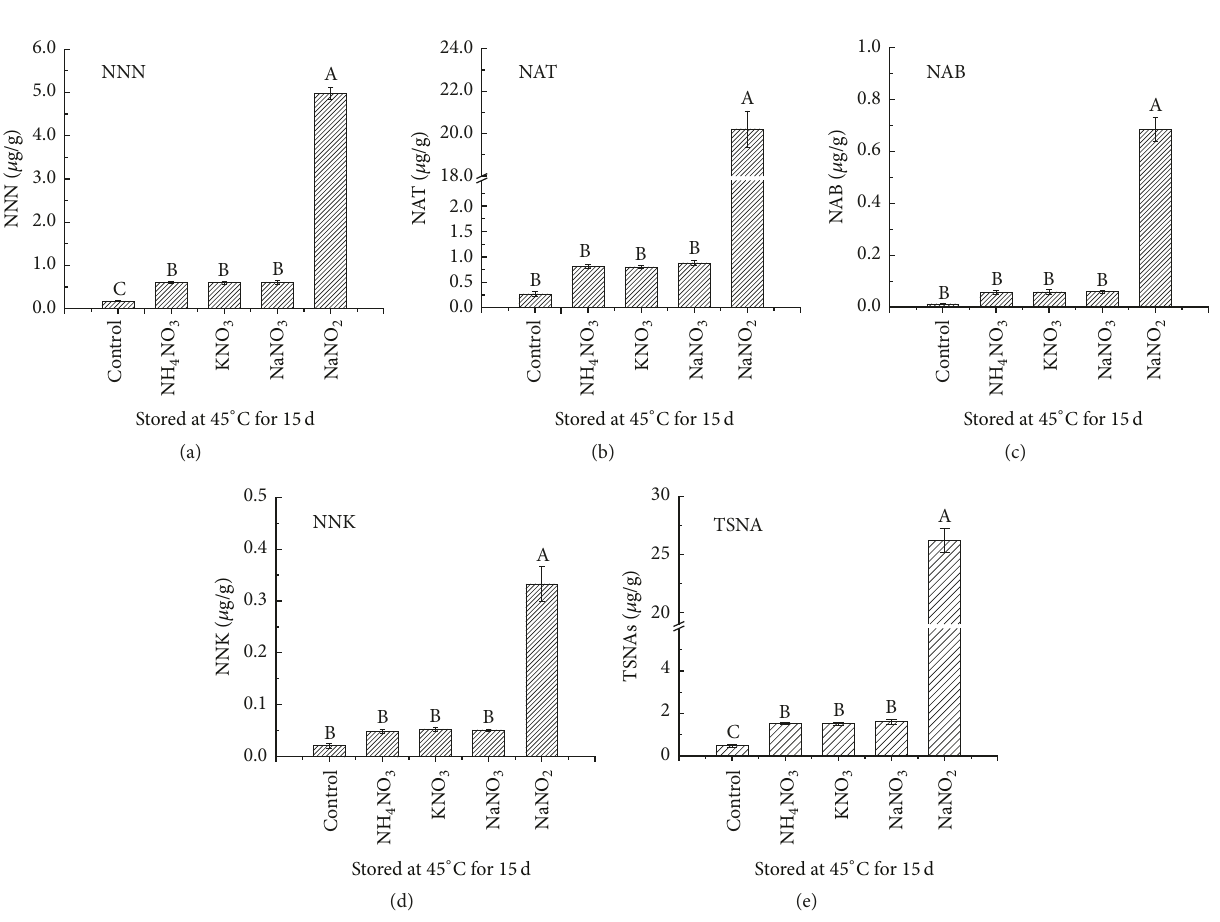
Figure 4: Effects of indirect addition of three nitrate compounds and sodium nitrite on TSNAs formation in flue-cured tobacco during warm temperature storage. Note . The 1mol/L of nitrate, nitrite compounds (310 mg of NO 3− and 230 mg of NO 2− , resp.), and tobacco were added separately in the closed vessel which was then stored at 45 ∘ C for 15 d. Uppercase letters indicate significant differences between the treatments at 𝑃 < 0.05